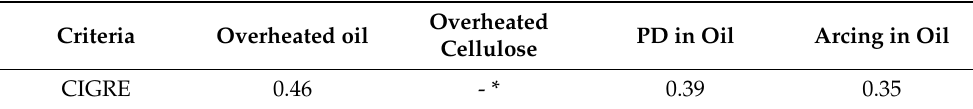
Table 9. The calculated monthly increases in the health index score for faults identified by the Key Gas Method with the use of daily pre-failure gas increase rates indicated by CIGRE. Criteria